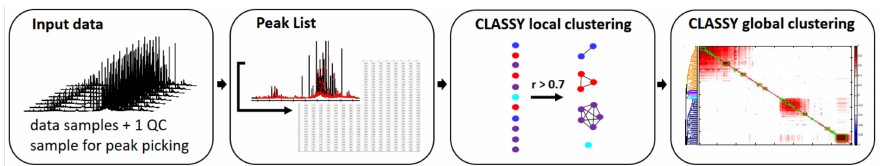
Figure 2. Overview of the CLASSY approach adopted from Robinette et al. Input data includes data samples and a QC sample. A peak-picking approach with the QC sample as reference generates the peak list. The CLASSY approach is comprised of a local clustering that finds peaks that cluster (Spearman correlation, see green boxes in the CLASSY clustering output figure also in Figure 3) and a global clustering based on HCA analysis for re-arrangement of the local clusters. The CLASSY output figure gives information on the peak clusters (green boxes), the exact correlation coefficient (colour-code red to blue) and a HCA dendrogram of all re-arranged peak